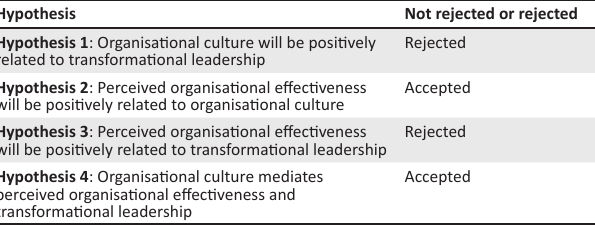
TABLE 9: Hypothesis description and decision.